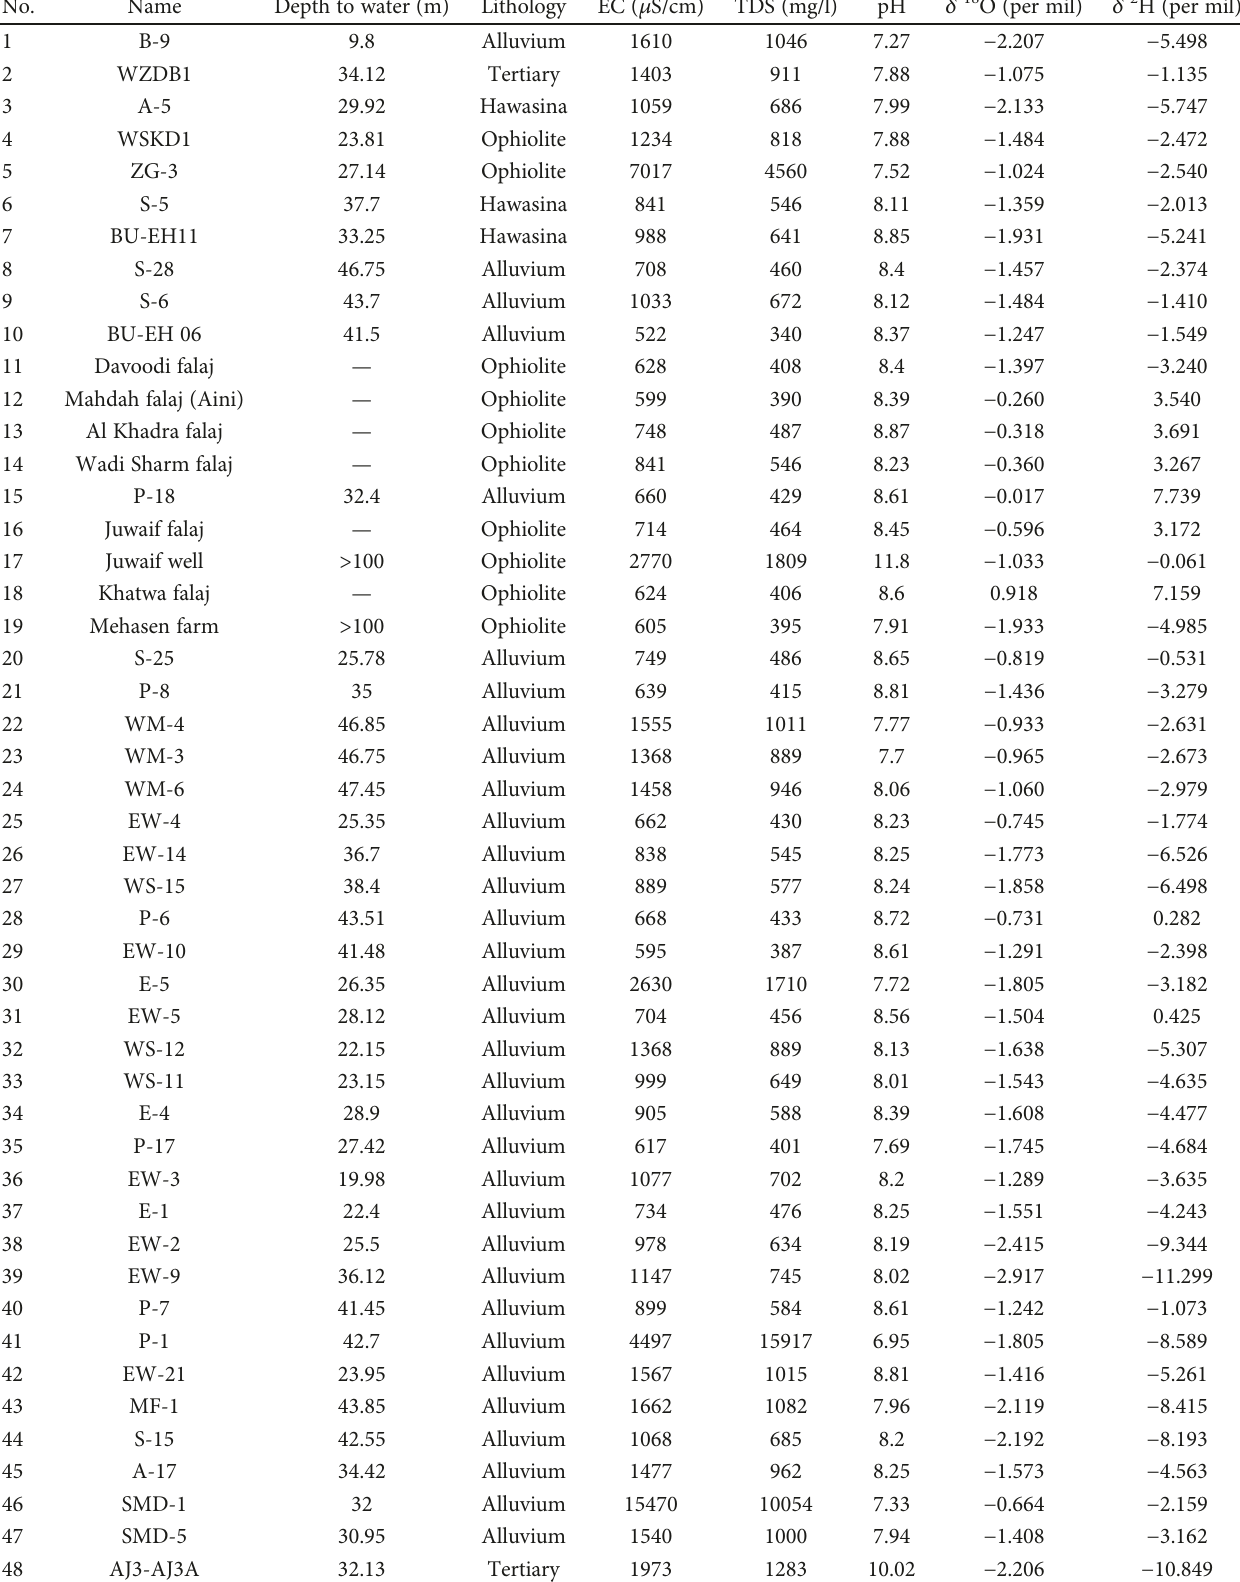
Table 1: Field parameters, physical characteristics, and isotopic composition of groundwater